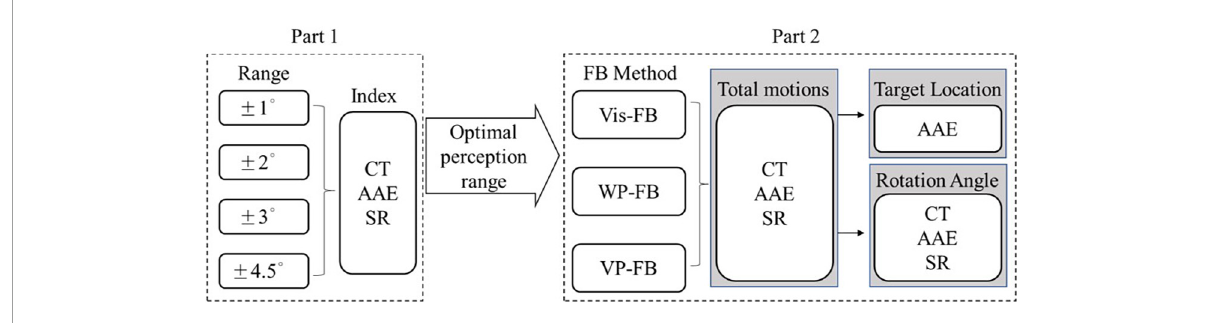
FIGURE1 The experiment procedure.